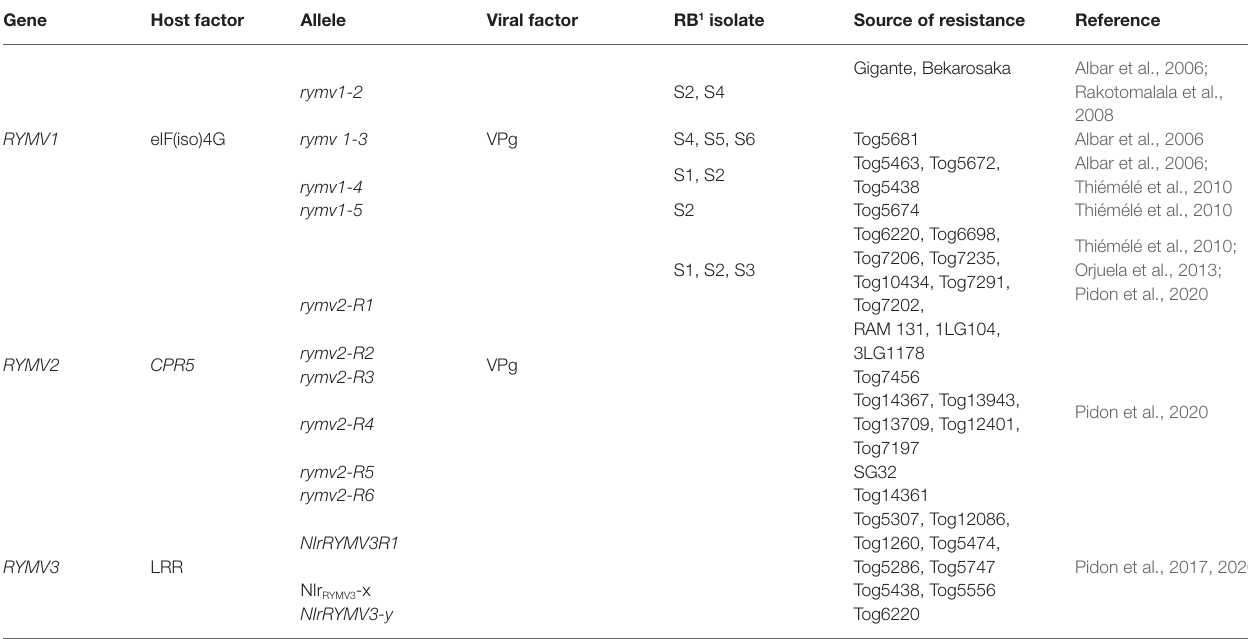
TABLE 1 | List of the resistant accessions and details of the resistance genes and their alleles. Gene Host factor Allele Viral factor RB 1 isolate Source of